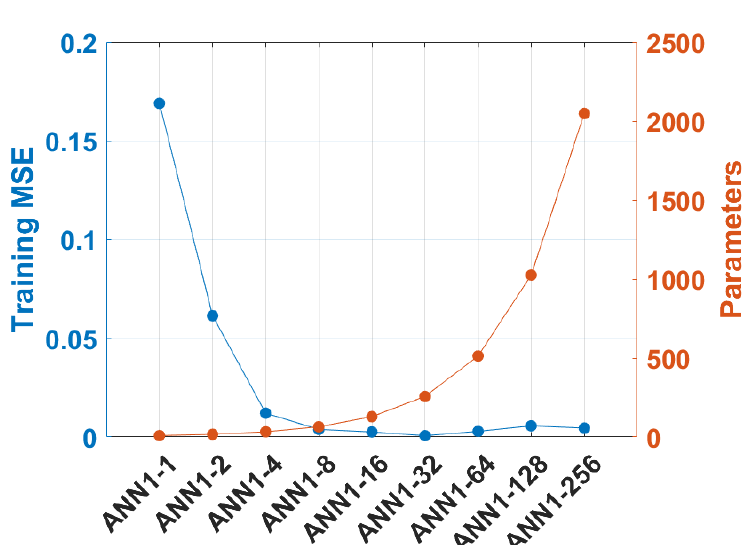
Figure 6. Training results for single-hidden-layer